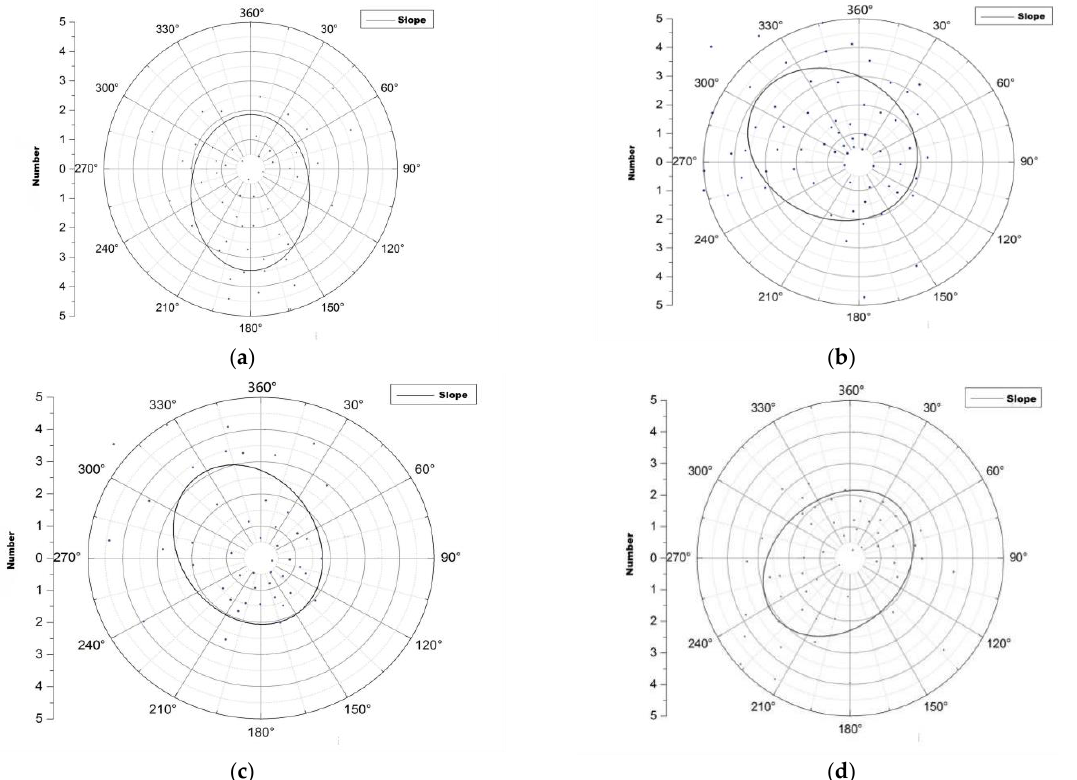
Figure 4. Spatial distribution of root sprouts of Malus sieversii on different slopes. ( a ) Spatial distribution direction of eastern slope root sprouts; ( b ) Spatial distribution direction of western slope root sprouts; ( c ) Spatial distribution direction of western slope root sprouts; ( d ) Spatial distribution direction of northern slope root sprouts. Table 1. Spatial distribution patterns of root sprouts on samples with different slope orientations using standard deviation ellipses. CenterX and CenterY represent the center points of the ellipse. XstdDist and YStdDist represent the length of the X-axis and the length of the Y-axis. Rotation is the angle of the direction of the ellipse. Aspect Eastern